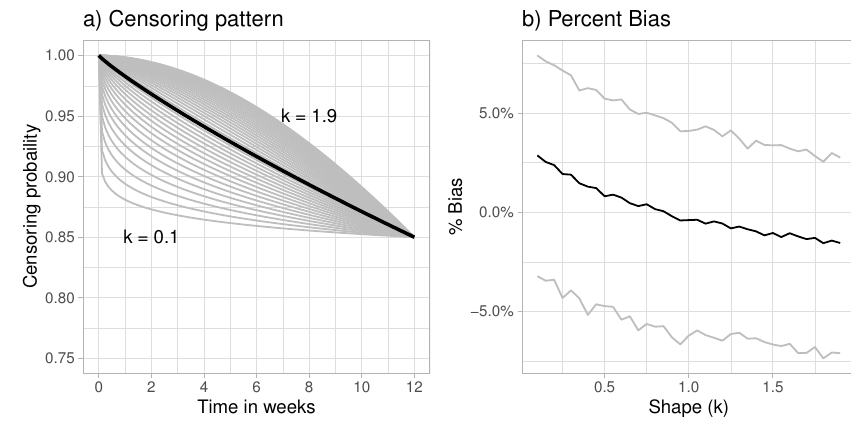
Figure 5 – The effect of model misspecification on the proposed estimator when the underlying distribution pattern is Weibull but calculation assumes exponential censoring distribution (a) and the recorded percent bias of the SE of the survival function at 12 weeks (b).